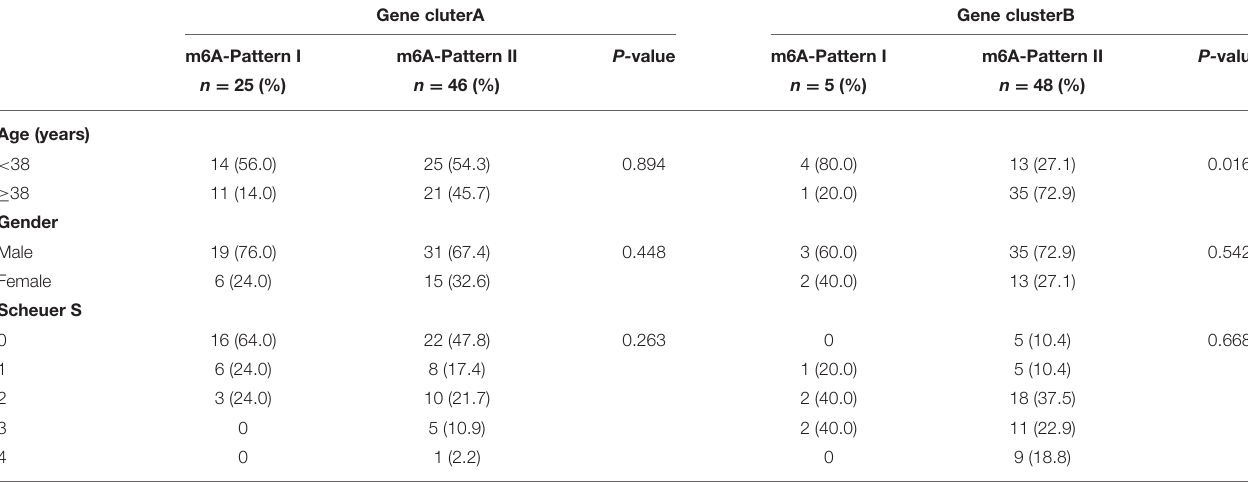
TABLE 3 | Age, gender, and Scheuer score (S) of both m6A-Patterns in gene clusterA and gene clusterB.